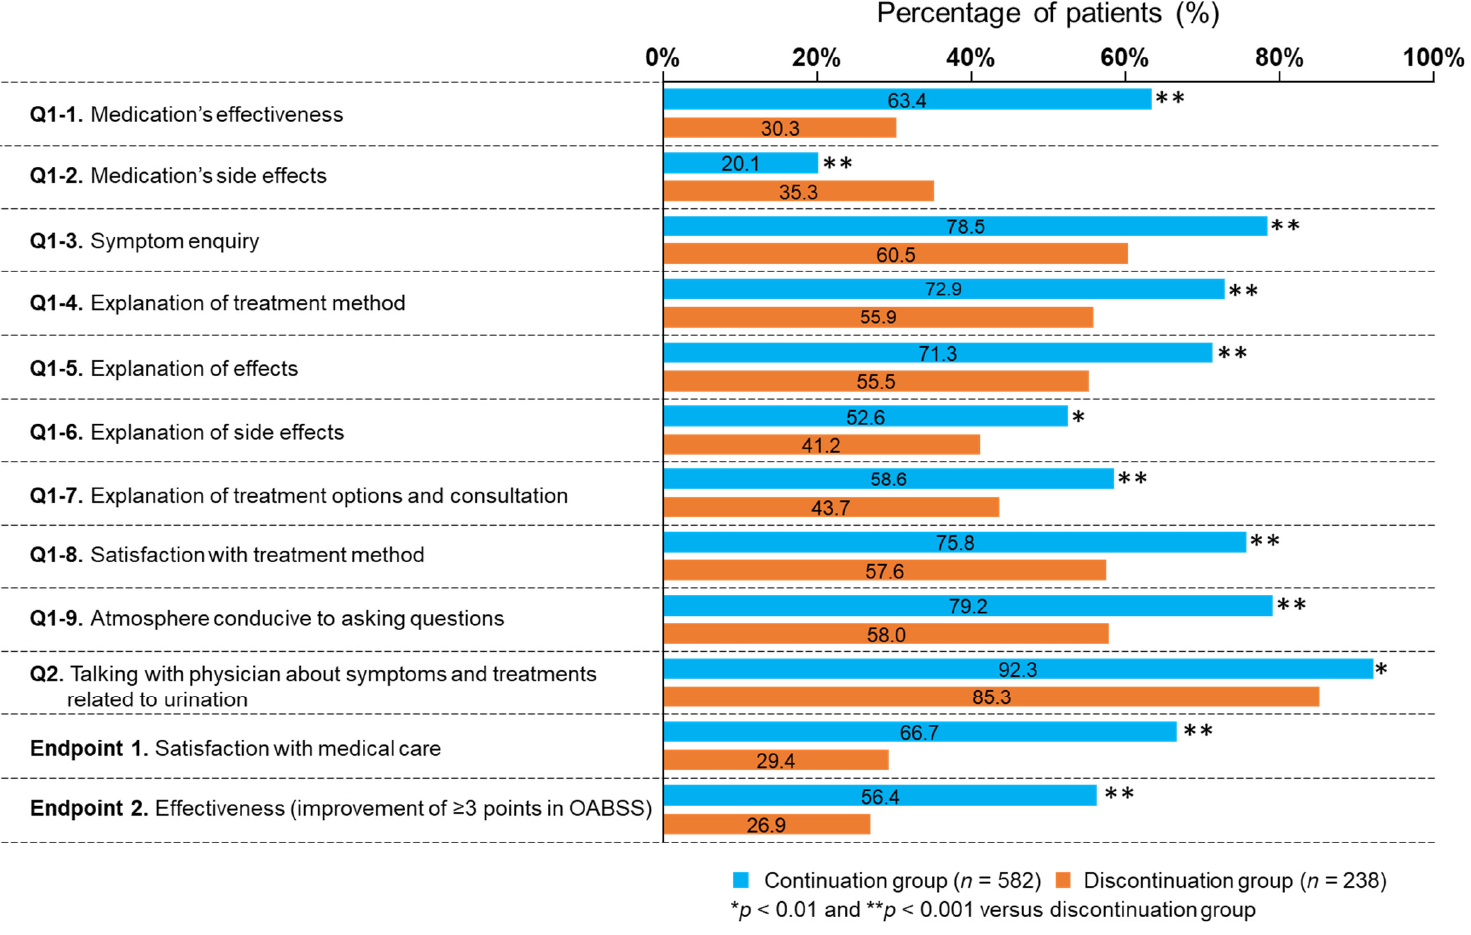
Figure 3. Comparison between patients who continued and those who discontinued overactive bladder medication. OABSS, overactive bladder symptom score.